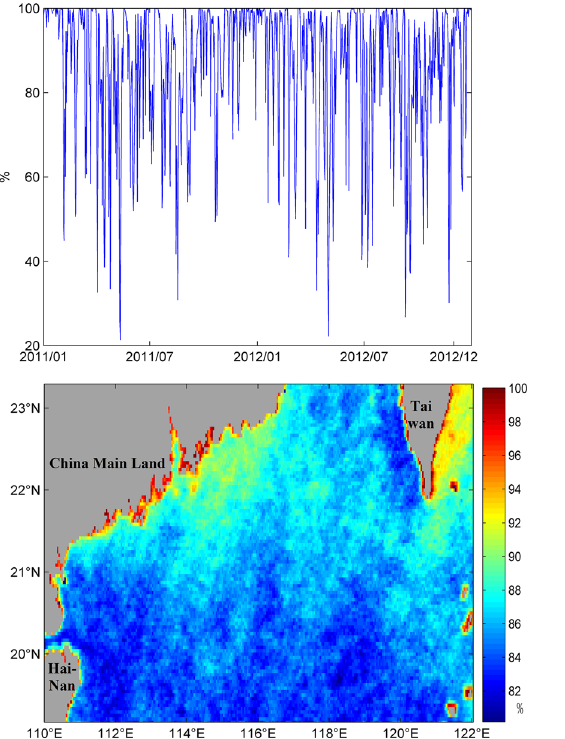
Fig 2. Top panel: temporal variation of missing data percentage in the NSCS. The year/month labels show the 1st of corresponding year/month. Bottom panel: spatial variation of missing data percentage in the